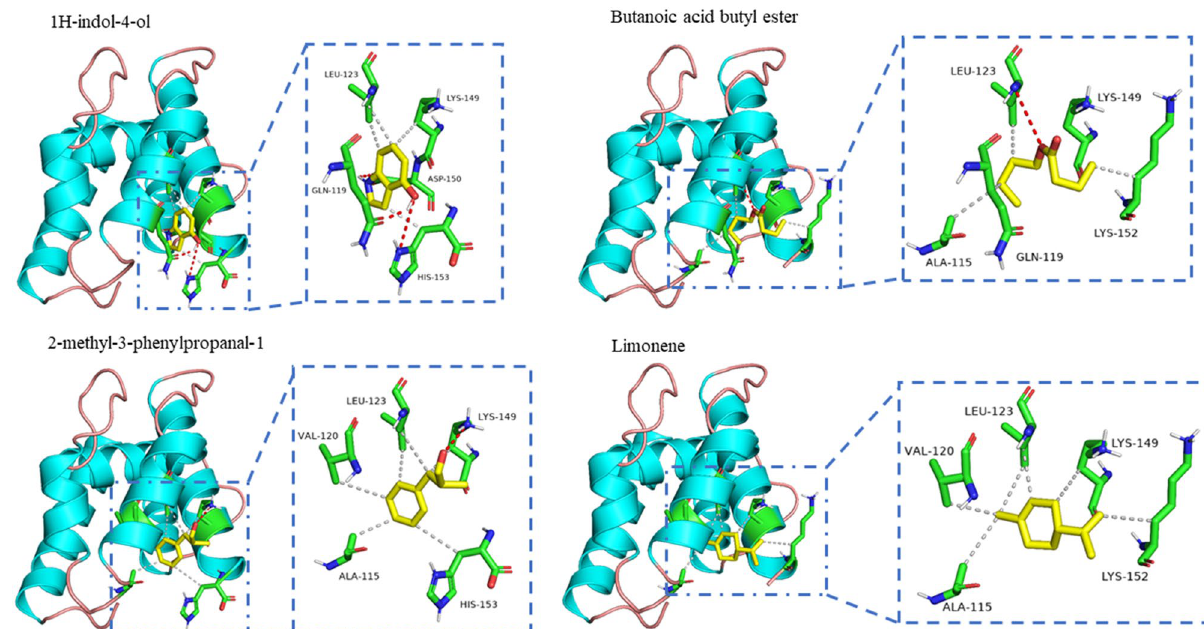
Figure 6. Molecular docking result of MvitOBP3 and host-plant volatile